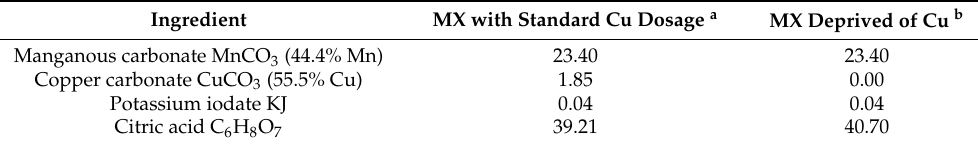
Table 2. Cont. Ingredient MX with Standard Cu Dosage a MX Deprived of Cu b Manganous carbonate MnCO 3 (44.4% Mn)